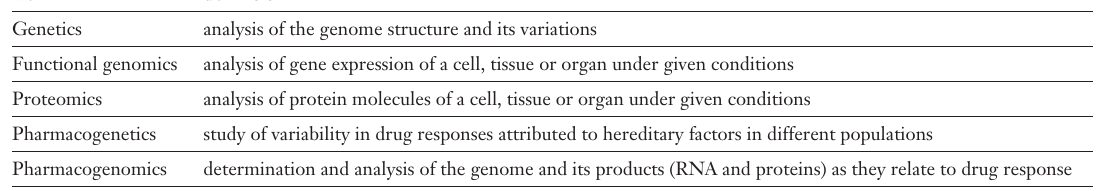
Levels of gene – function